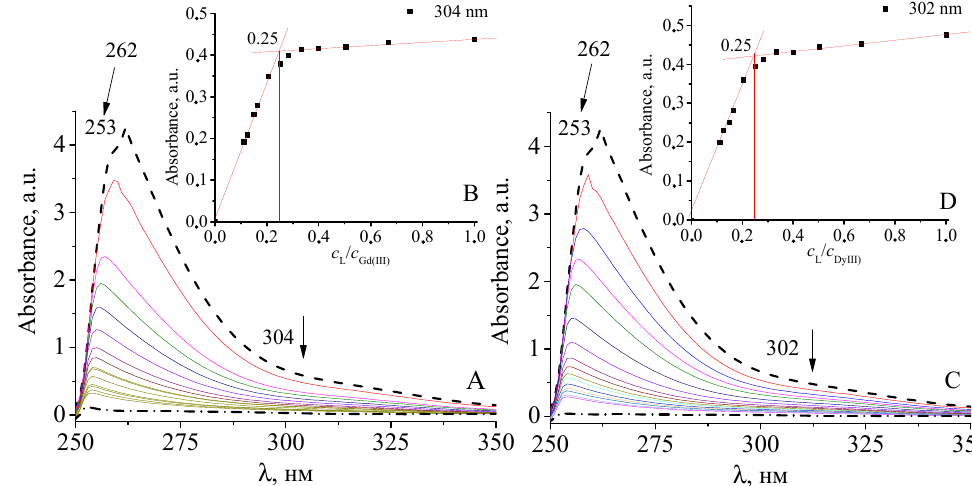
The electronic absorption spectra of the system [Gd(III) and Dy(III) salts—compound 2 ] were studied (Figure 7). The band at 262 nm (4.27 A) has a hypsochrome effect with a hypsochrome shift up to 253 nm (0.11 A for compound 3 and 0.04 A for compound 4 when the molar ratios of Gd(III)/Dy(III):compound 2 increase from 0.25:1 to 9:1 (Figure 7A,C)). The band at 304 nm (0.59 A) of compound 3 (Figure 7A) and the band at 302 nm (0.62 A) of compound 4 (Figure 7C) have only a hypsochrome effect to an optical density of 0.03 A and 0.02 A, respectively. All this indicates the participation of carboxylate anions in the coordination with lanthanide ions in the whole range of molar ratios studied. The overall spectral pattern of the [lanthanide(III)-compound 2 ] system is similar to the position of the absorption bands in the individual complexes 3 and 4 , indicating the identity of the coordination unit geometry in the condensed phase and in solution, and confirming the realization of the coordination unit geometry with Gd(III) and Dy(III) ions of the square anti-prism type [48,49].